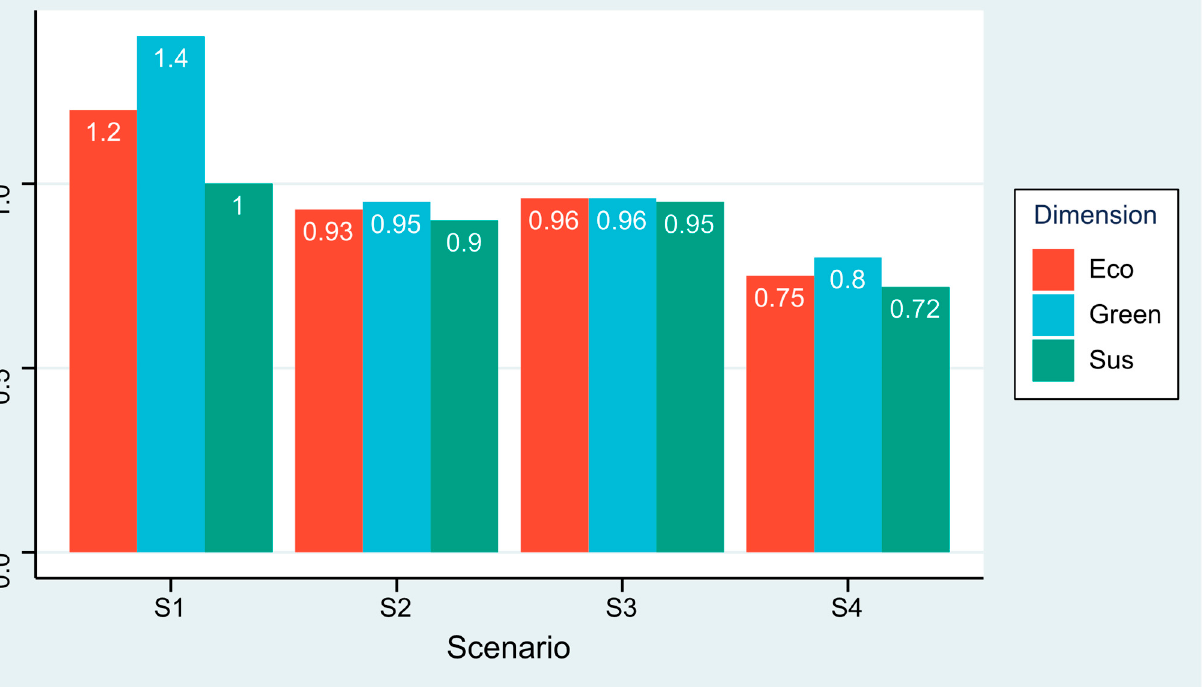
Figure 6. Results of sensitivity analysis of sustainability dimensions of 𝑓 (cid:3032)(cid:3041)(cid:3049) . Figures 5 and 6, respectively, show the results of the sensitivity analysis of the sus- tainability dimensions of the economic and environmental objectives for each scenario. It should be added that the value of the social objective function is constant when the di- mension is changed, so the results of the analysis for this objective are not presented here.